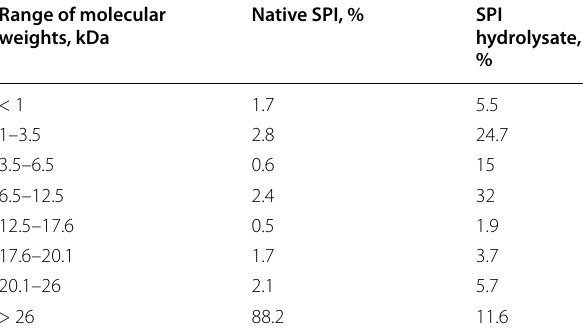
Table 2 Distribution of molecular weights of proteins and peptides of native and hydrolyzed soy protein isolate (SPI) according to size exclusion chromatography results Range of molecular weights,